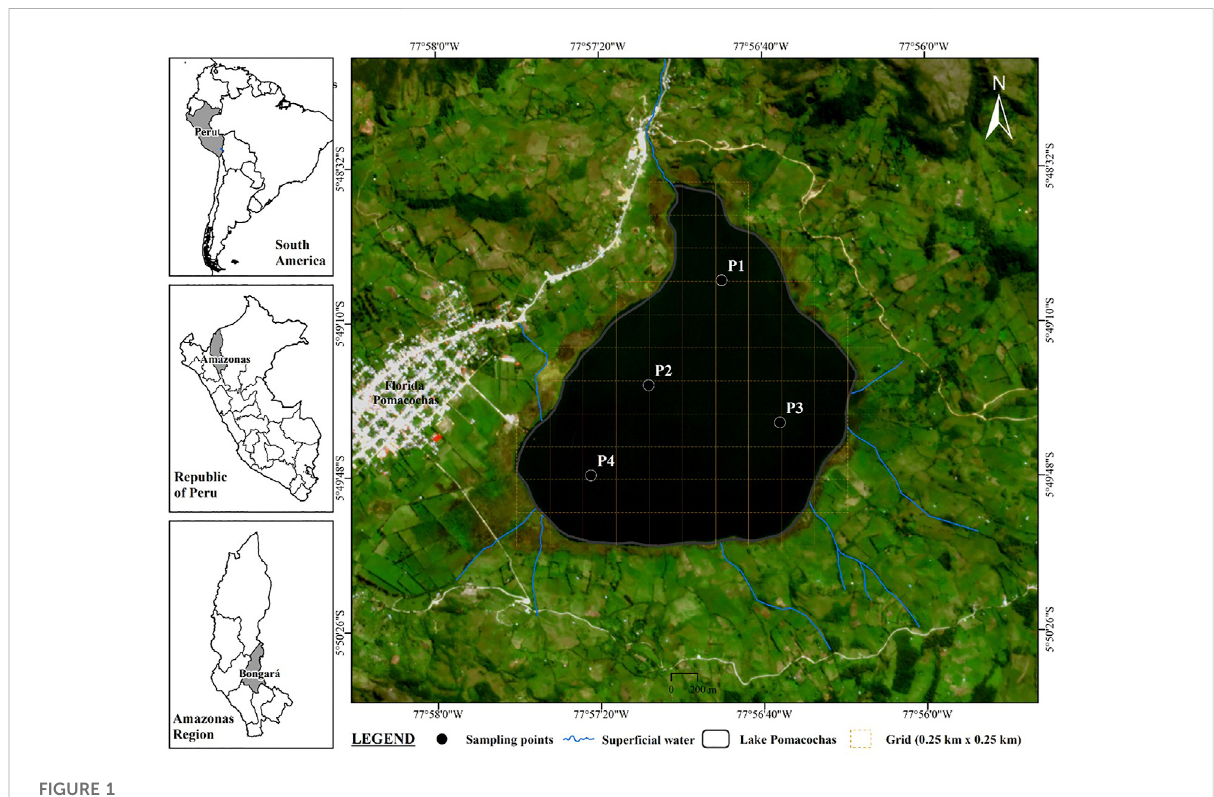
FIGURE 1 Geographic localization of study